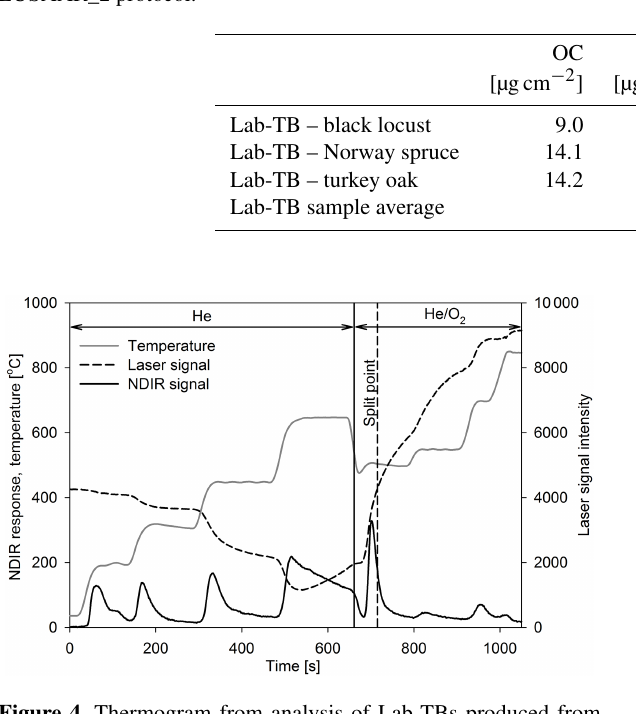
Table 3. Organic carbon (OC), elemental carbon (EC), total carbon (TC) content and ratio of elemental carbon to total carbon content (EC / TC) (RSD% of 3 Lab-TB samples) of laboratory-generated tar balls (Lab-TBs) on quartz filters (spot ∅ 13 . 06mm) obtained by the EUSAAR_2 protocol.